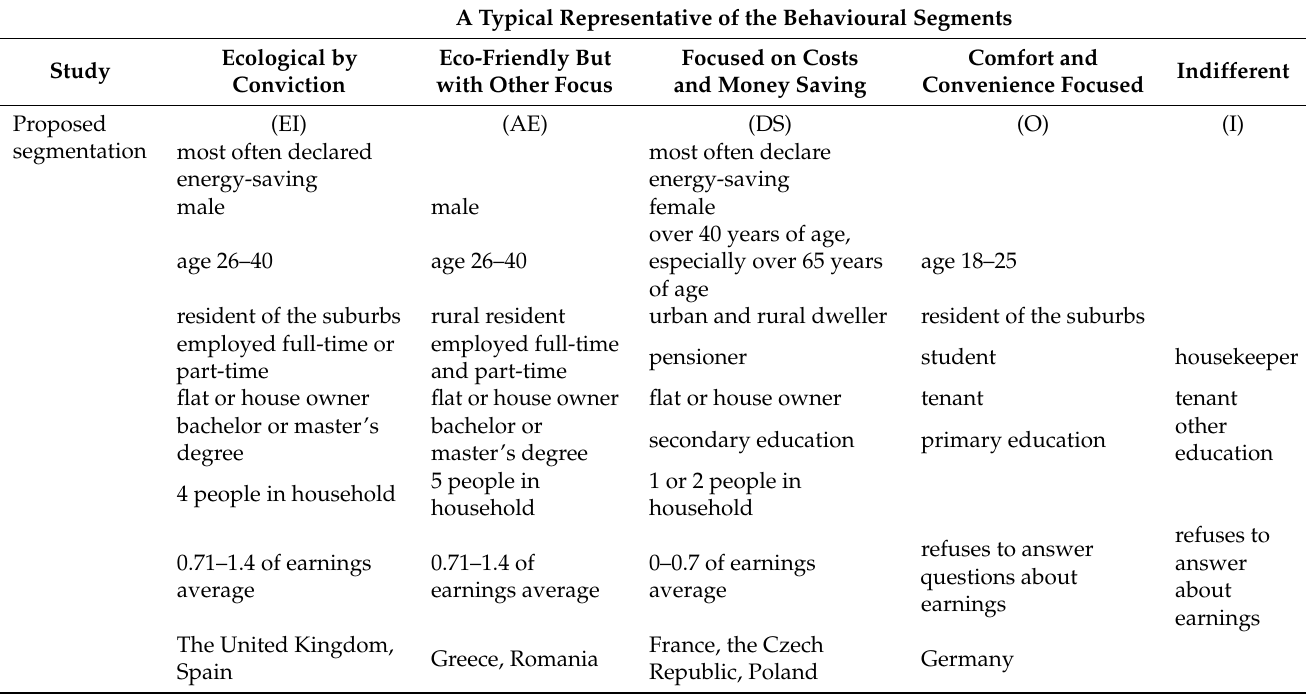
Table 3. Characteristics and comparison of a typical representative in selected existing energy consumer segmentations. A Typical Representative of the Behavioural